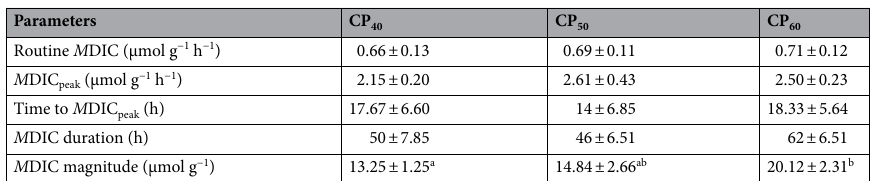
Figure 4. Nitrogen quotient (NQ) in juvenile Sagmariasus verreauxi . Lobsters were reared at 21 °C and fed 15 N-labeled feeds at 1.5% body weight at three crude protein levels: 40%, 50% and 60%, corresponding to CP CP 50 and CP 60 treatments, respectively. The NQ at − 2 h indicates the routine NQ. The first post-prandial NQ was recorded at 0 h. All data represent mean ± standard error (SE) of 6 individuals.